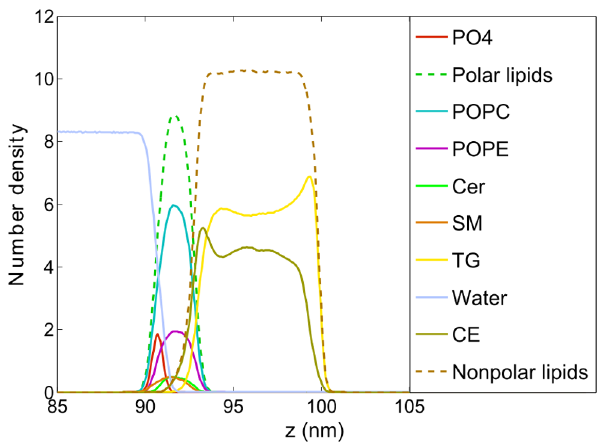
Figure 3. Density profiles of the system components at APPL=68 A˚ 2 . The data are averaged over the simulation time from 0.2 m s to 1.2 m s.